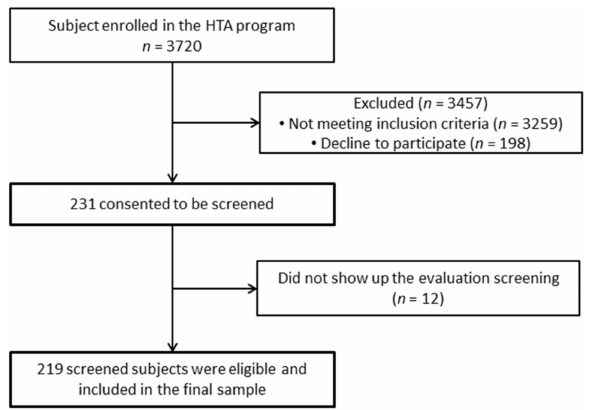
Figure 1. Flowchart diagram of the participants in this